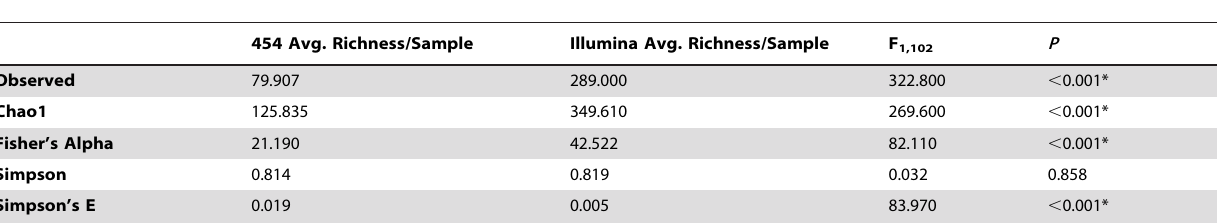
Table 2 . Average per-sample fungal richness for 55 soil samples from pine